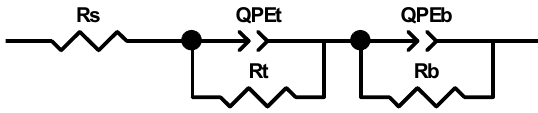
Figure 6. Electrical equivalent circuit model used for fitting the impedance spectra of the Ti_NT org samples.